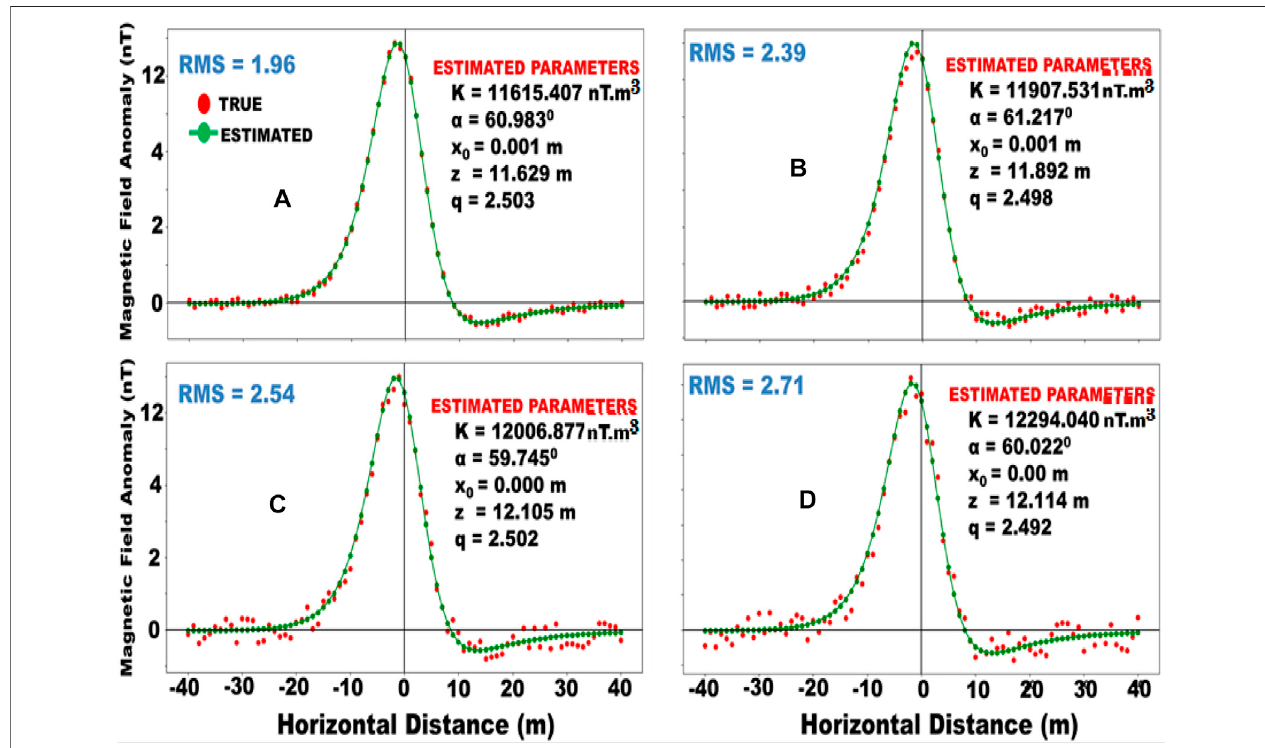
FIGURE4| Syntheticallygeneratednoisyandestimated(MFR)magneticanomaliesforaspheremodelwithK=11,000 nT.m3,z=11 m,q=2.5, α =600,xo=0 m with (A) 5% (B) 10% (C) 15% (D) 20% gaussian random error.